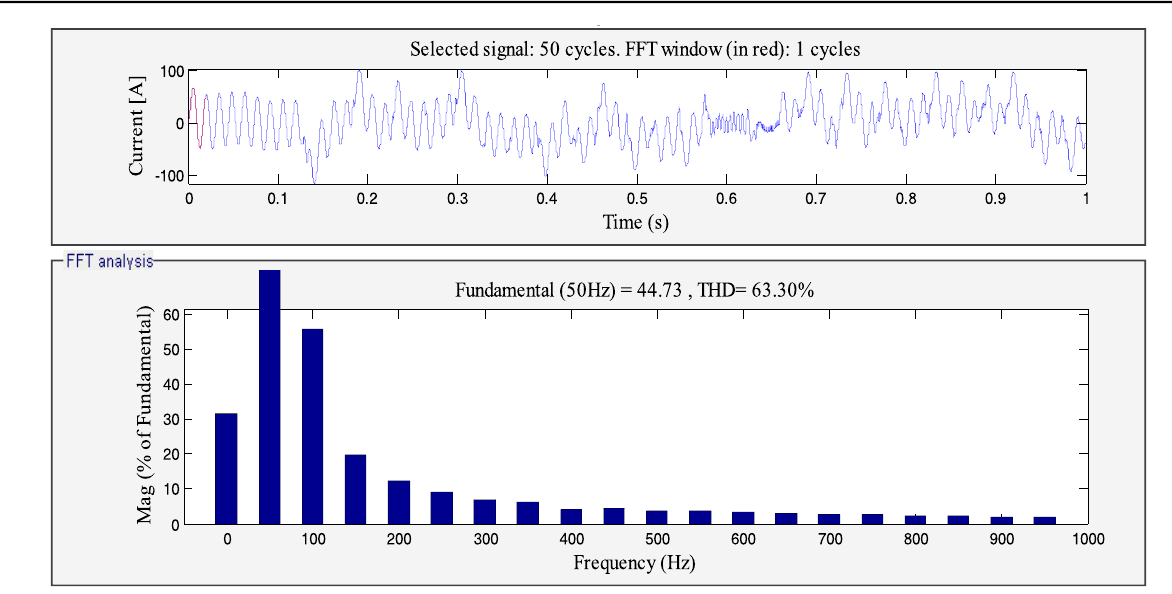
FIG.11. INPUT CURRENT TO MOTOR AND ITS HARMONIC ANALYSIS WITH SVPWM